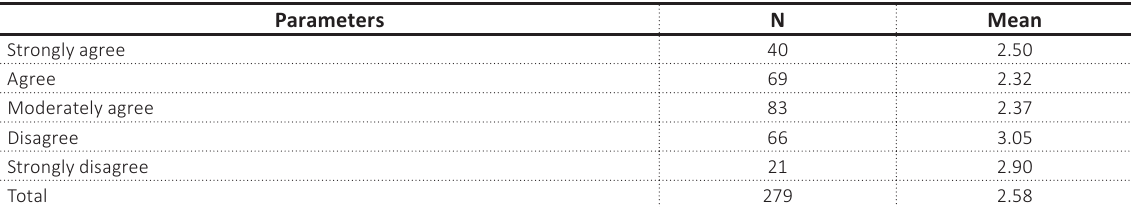
Table 13. Transparency and tax compliance mean extracts